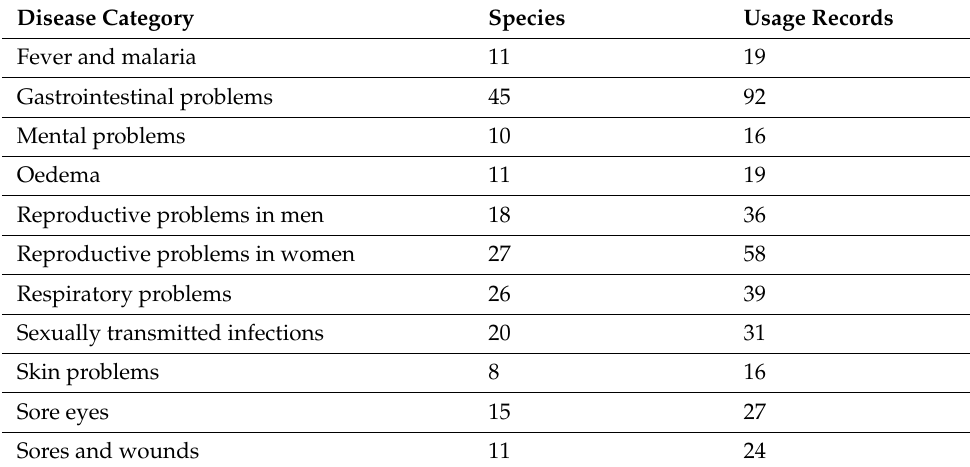
Table 2. Cont. Disease Category